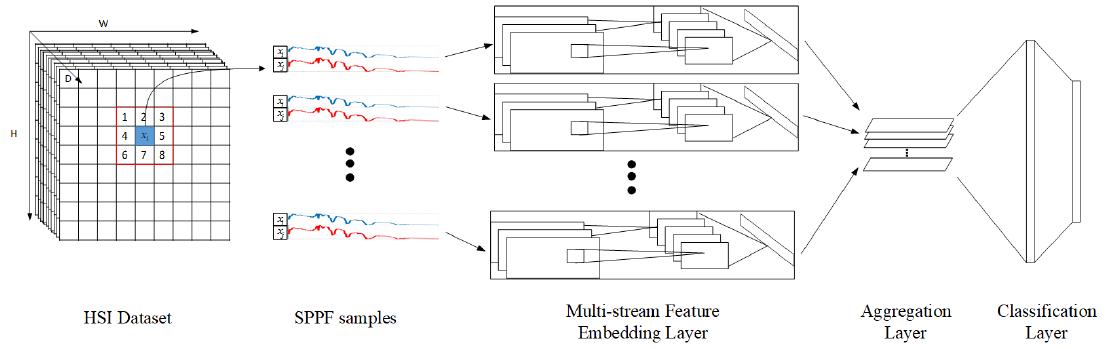
Figure 2. Proposed classification framework for HSI classification based on SPPF